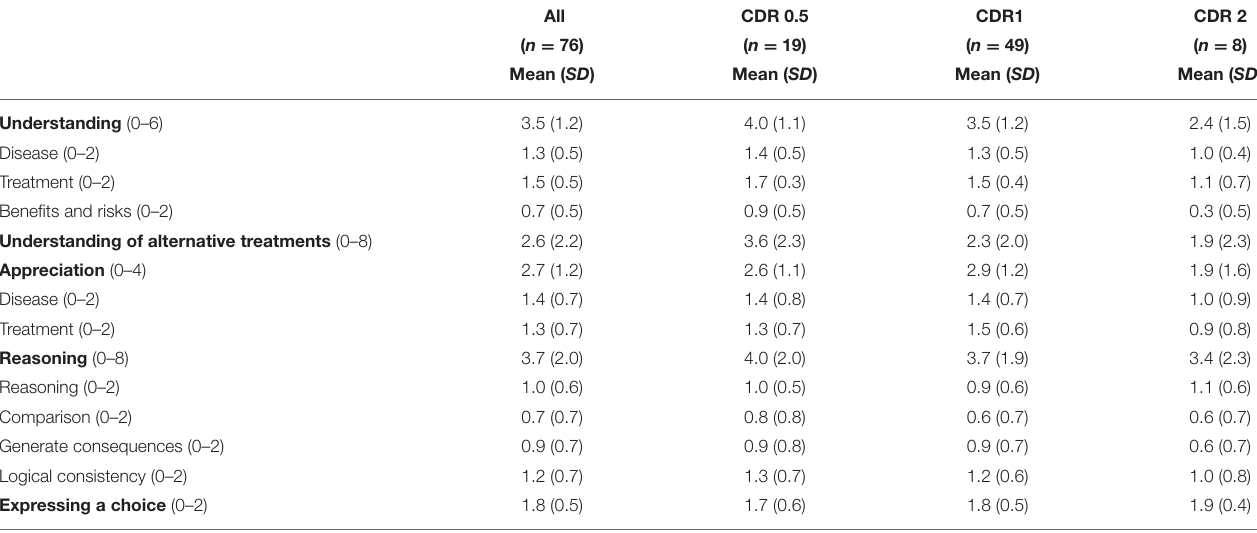
TABLE 3 | MacCAT-T performance.